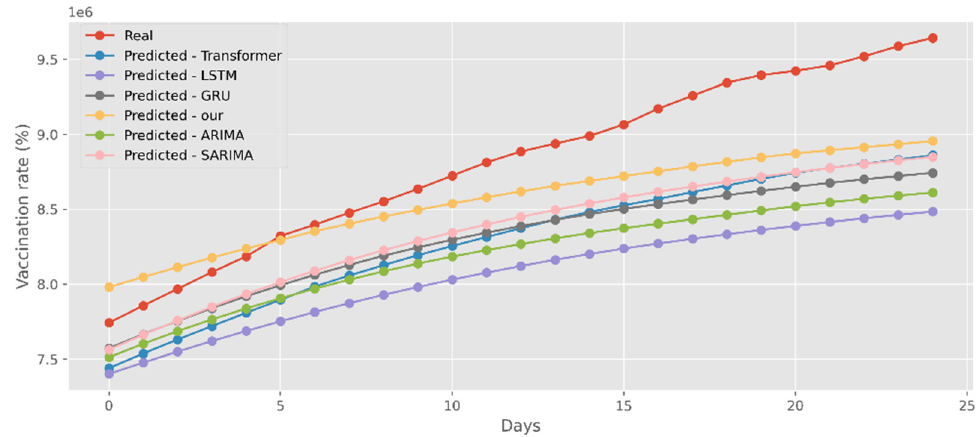
Figure 18. Comparison of COVID ‐ 19 prediction models of vaccinated in CA.